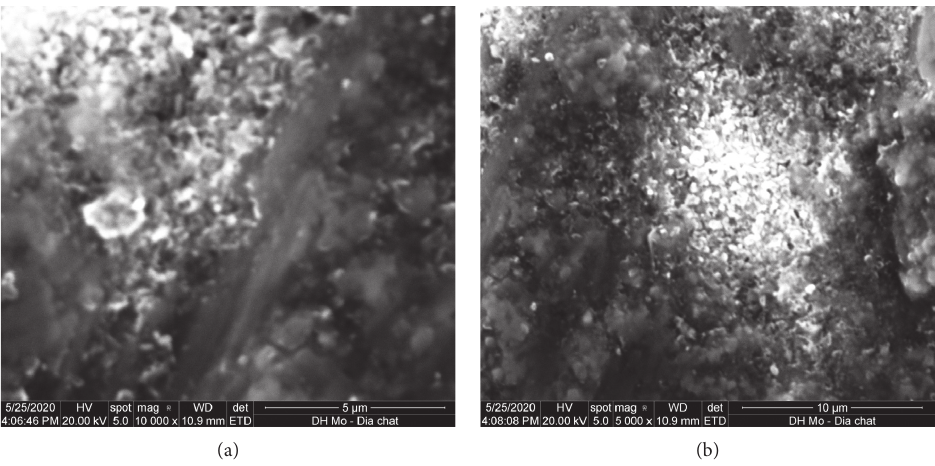
Figure 3: Microstructure of the ceramics sintered in the open air (a) and in a vacuum environment (b).